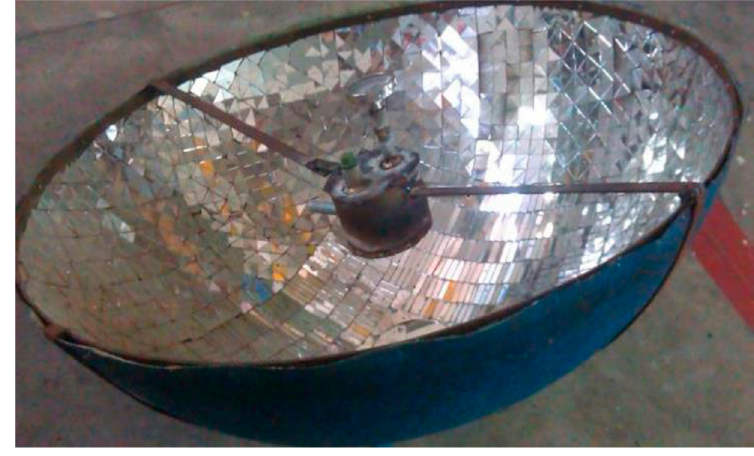
Figure 7. Manufactured solar concentrator.